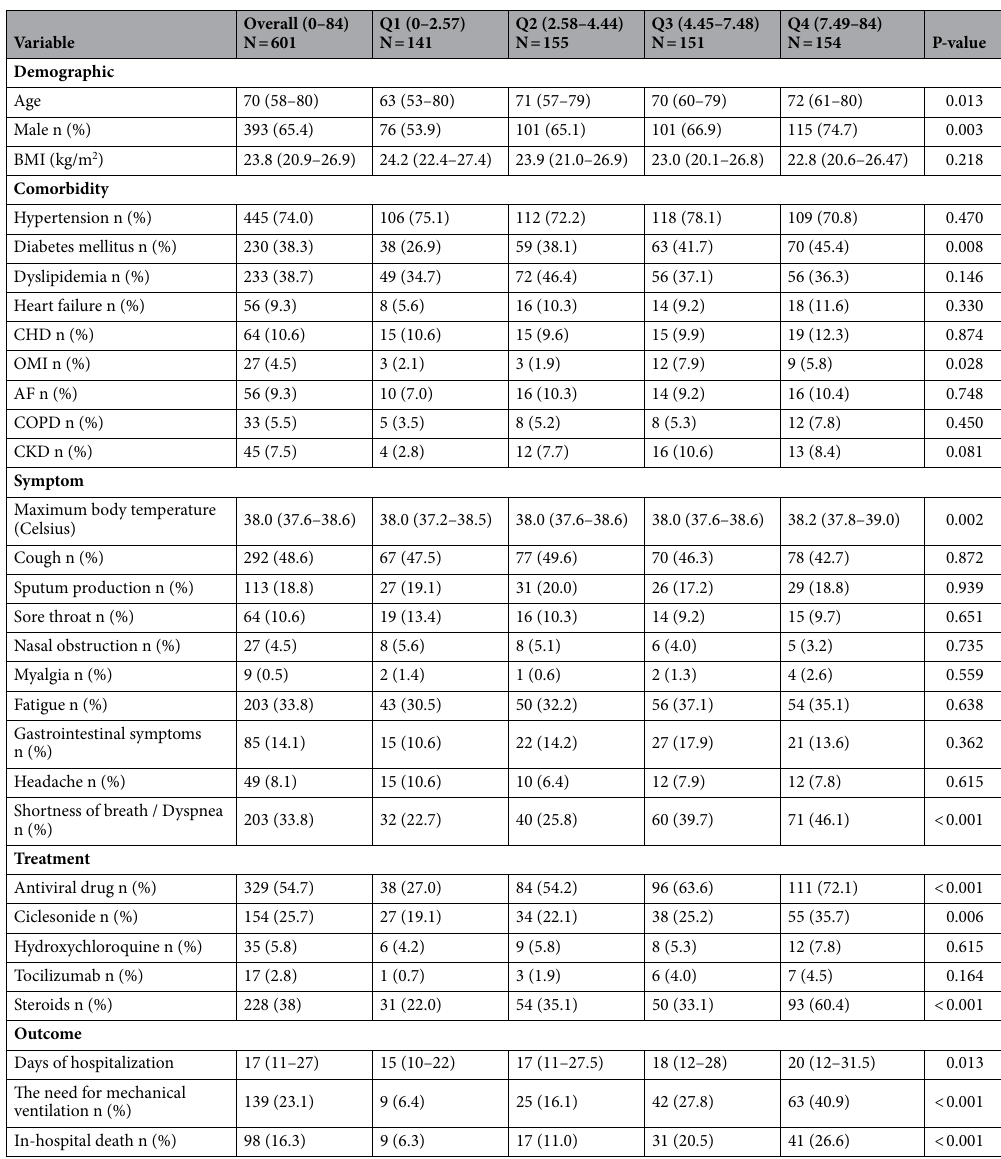
Table 1. Demographics and clinical characteristics of COVID-19 patients according to baseline NLR quartiles. Data are shown as percent for categorical and as median (IQR) for continuous variables. CHD coronary heart disease, OMI old myocardial infarction, AF atrial fibrillation, BMI body mass index, COPD chronic obstructive pulmonary disease, CKD chronic kidney